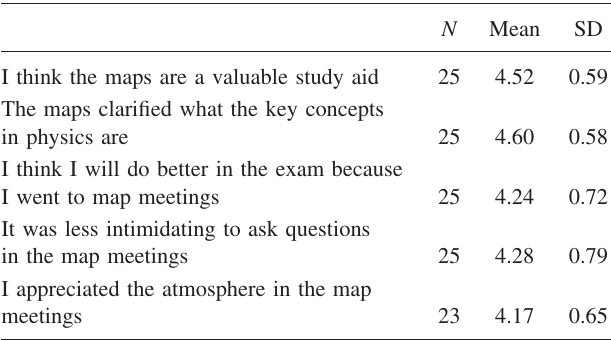
TABLE I. Descriptive statistics of the response from persistent map meeters to statements about map meetings.